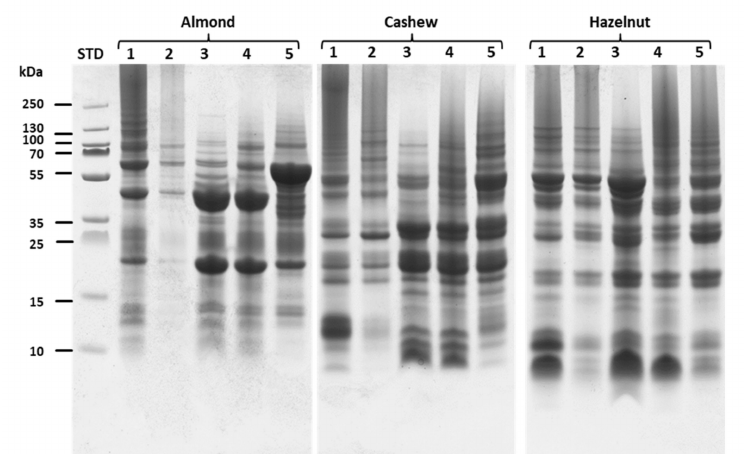
Figure 1. SDS PAGE band profiles of the extracted proteins of almond, cashew and hazelnut. Lines 1, 2, 3, 4 and 5 of the SDS PAGE pictures represent samples from ambi/urea, CM/NaCl, PVPP, SDS and TCA extraction methods, respectively.